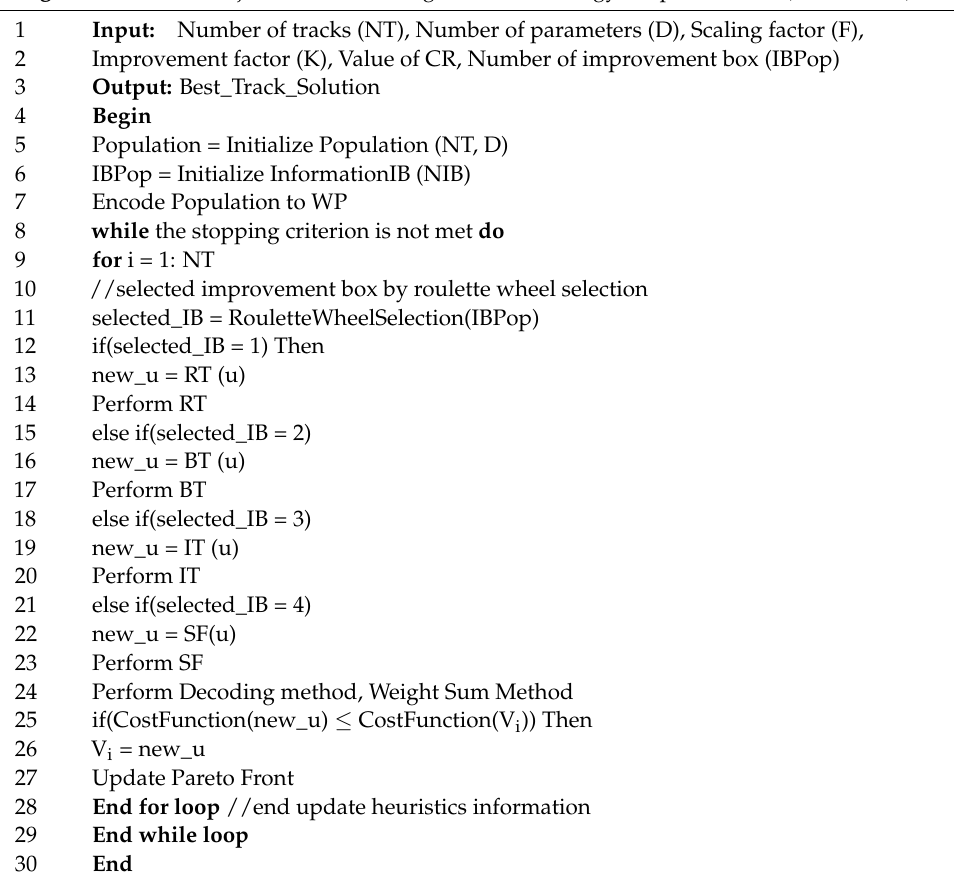
Algorithm 1: Multiobjective variable neighborhood strategy adaptive search